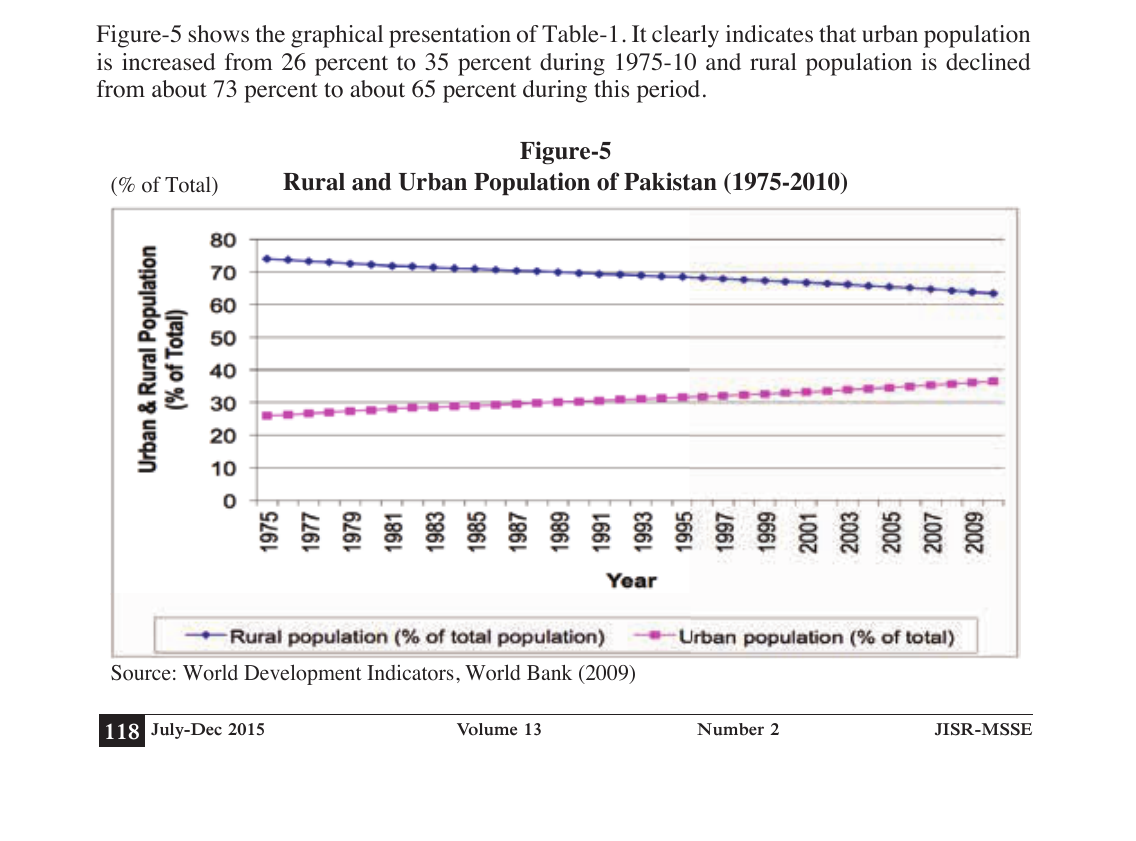
Rural and Urban Population of Pakistan